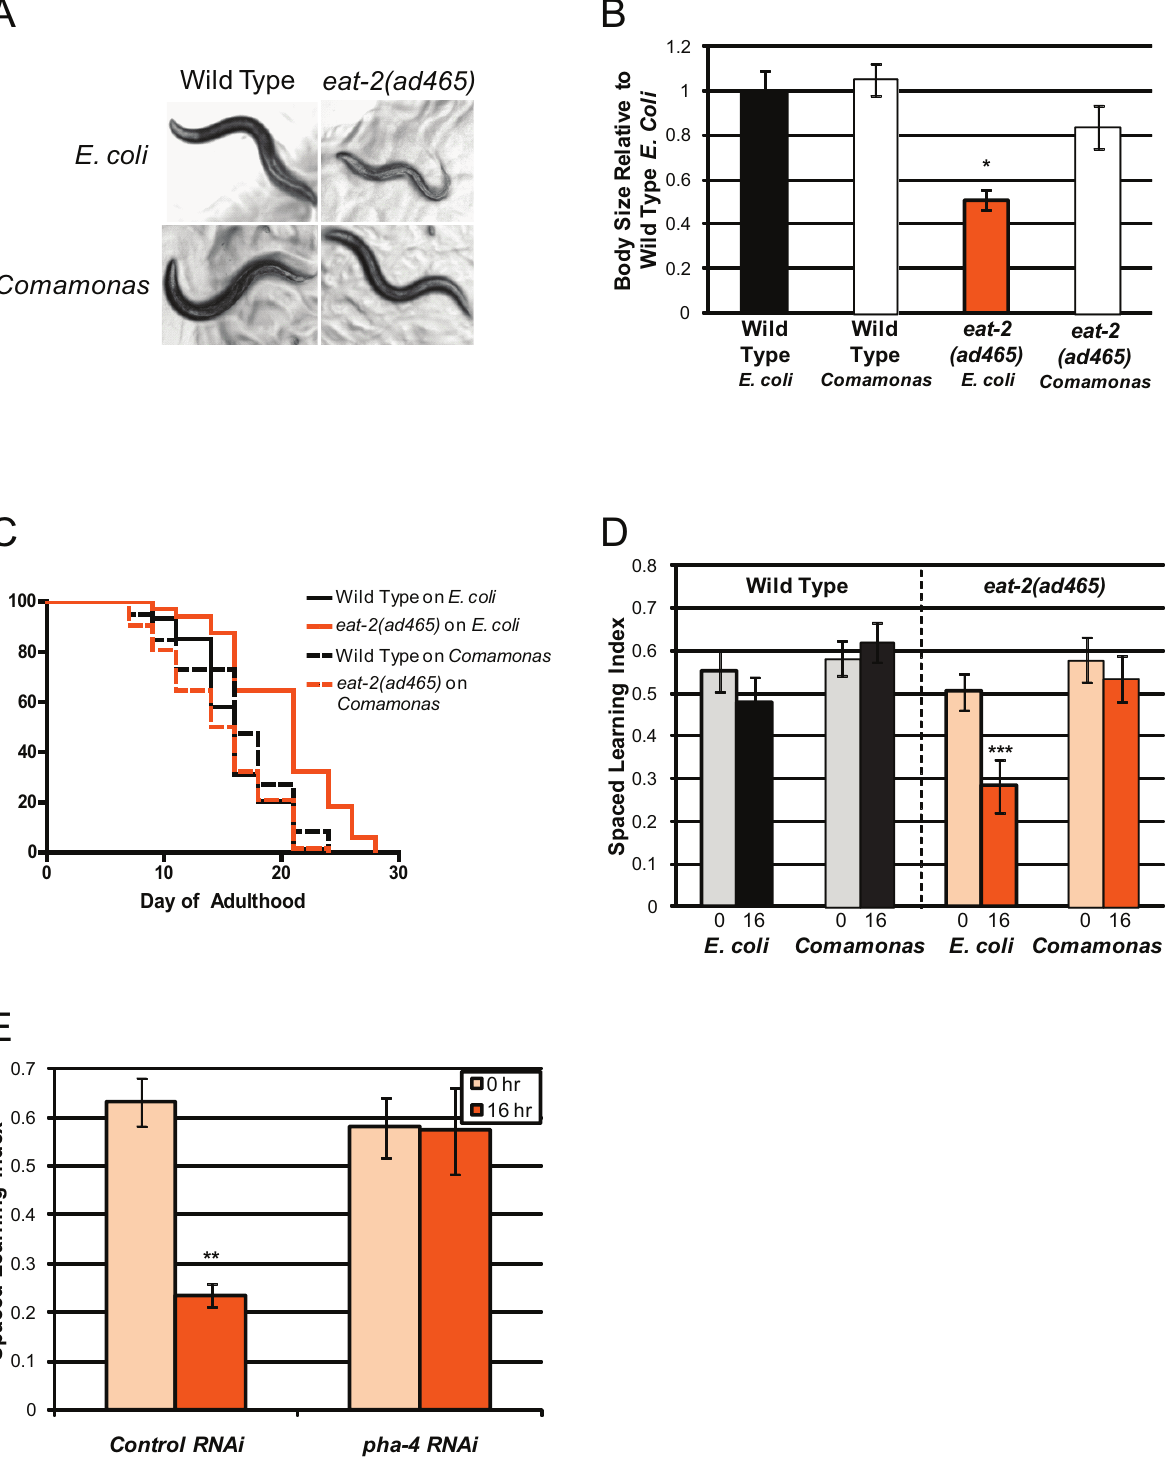
Figure 7. Feeding eat-2 worms with Comamonassp. rescues Dietary Restriction phenotypes. (A) When fed standard food of E. coli , eat- 2(ad465) mutants exhibit a small body size compared to wild type. eat-2(ad465) mutant body size is rescued by feeding animals small bacteria ( Comamonas ). (B) Quantitation of body size represented in (A). (C) The extended lifespan of eat-2(ad465) mutants is suppressed by feeding with Comamonas . (D) Feeding with Comamonas rescues eat-2(ad465) animals’ 16 h memory defect but does not significantly affect wild type’s memory. (E) Treatment of eat-2(ad465) worms with pha-4 RNAi abolishes LTAM defect. (B): n =3 Day 1 adult worms; photos are at same magnification; (C): n . 70, WT/ E. coli versus eat-2 / E. coli : p , 0.001; versus eat-2 / Comamonas : p =0.43; versus WT/ Comamonas : p =0.11; (D–E): Numbers under bars represent hours after 7 6 spaced training; (D): n =6 trials; (E) n =3 trials; 6 SEM; * p , 0.05, ** p , 0.01, *** p , 0.001.